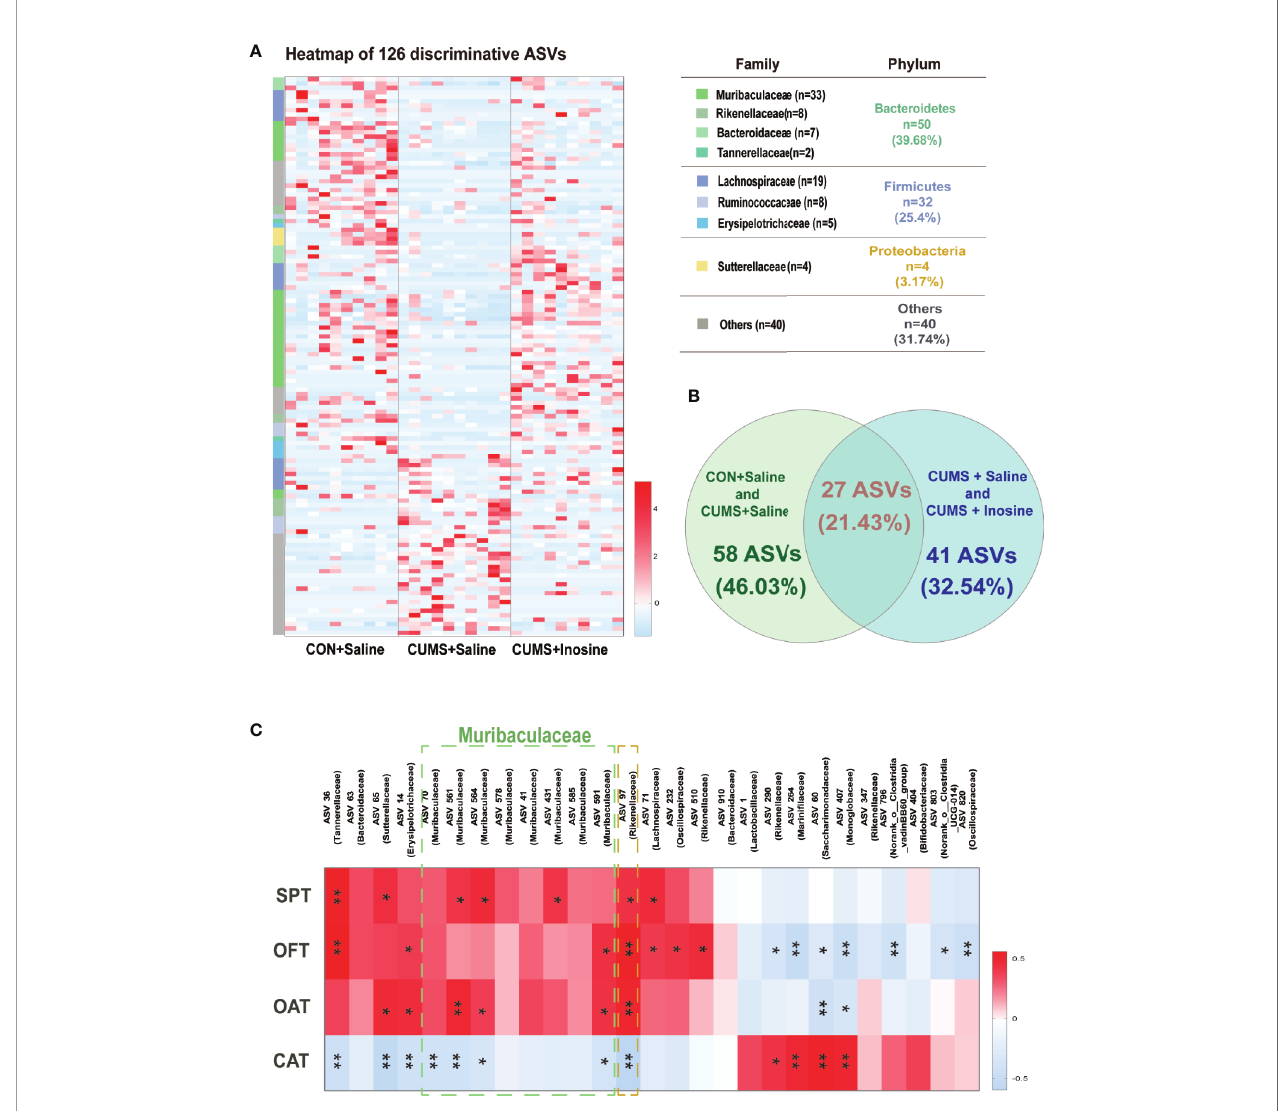
FIGURE 4 | The discriminative ASVs among three groups and the association between discriminative ASVs and depressive and anxiety-like behaviors. (A) Heatmap of the 126 discriminative ASV abundances among the CON+saline, CUMS+saline, and CUMS+inosine groups (linear discriminant analysis (LDA) >2.0). ASVs (raw) were sorted by taxa and classi fi ed at family and phylum levels. The intensity of color in the middle heatmap (blue to red) indicated the normalized abundance score for each ASV. (B) Venn diagram for discriminative ASVs among the three groups. Green designates enriched different ASVs between the CON+saline and CUMS+saline groups; blue designates enriched discriminative ASVs between the CUMS+saline and CUMS+inosine groups. (C) Heatmap of Spearman ’ s rank the correlations between behavioral indices and bacterial abundance of mutual discriminative ASVs; * p < 0.05, ** p <